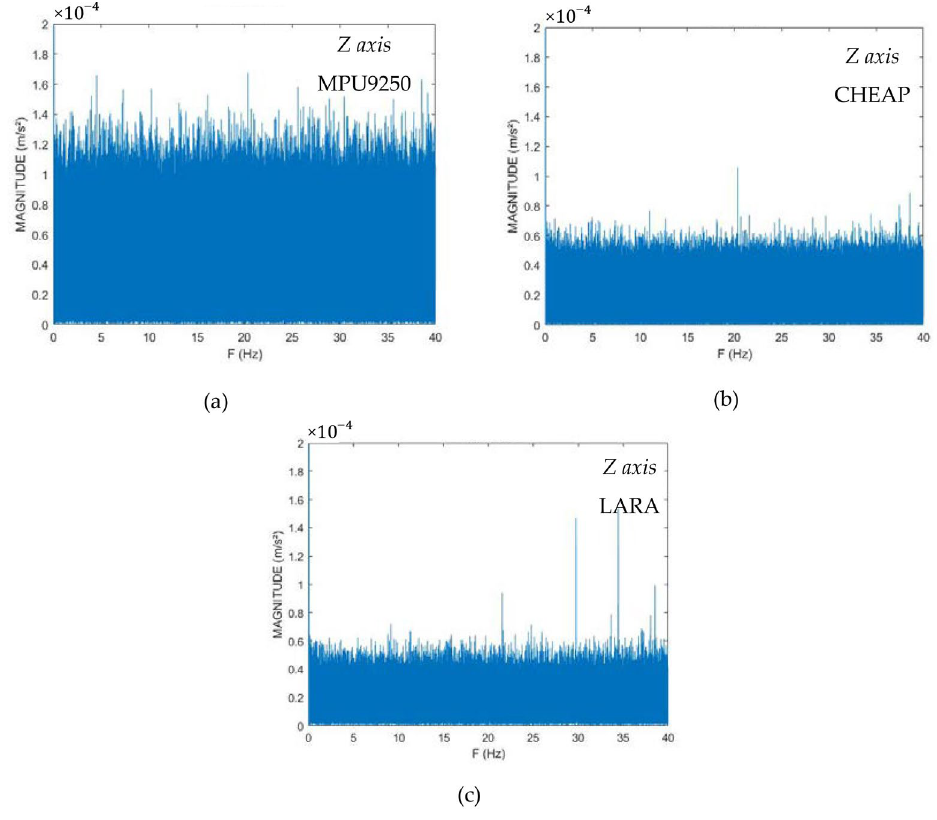
Figure 2. Frequency domain diagrams for z axis of: ( a ) MPU9250, ( b ) CHEAP, and ( c ) LARA.